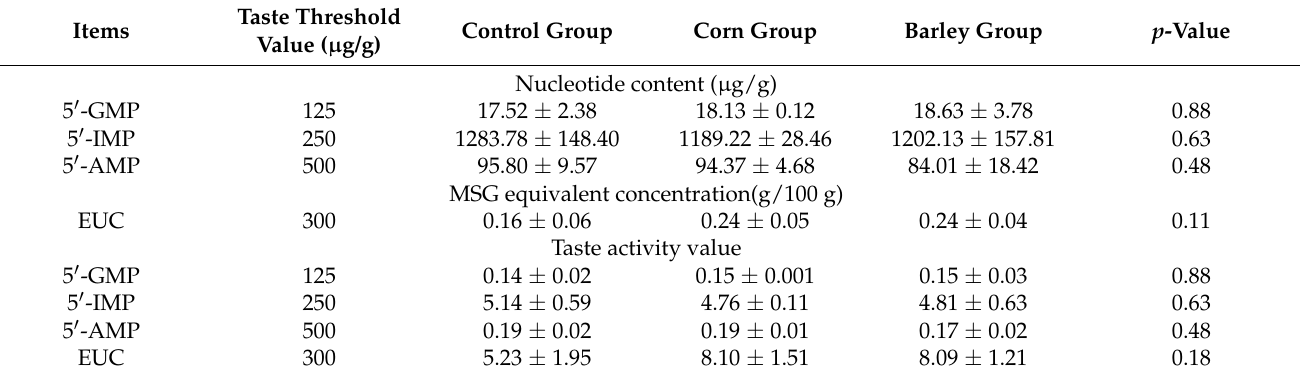
(Table 6). The shear force, water loss, and a* values were not significantly different between group ( p < 0.05), and the shear force and water loss were lower than those in the control group ( p < 0.01). Table 7. Effects of different carbohydrate source diets on the content of nucleotide, equivalent concentration of monosodium glutamate and taste activity value of beef.